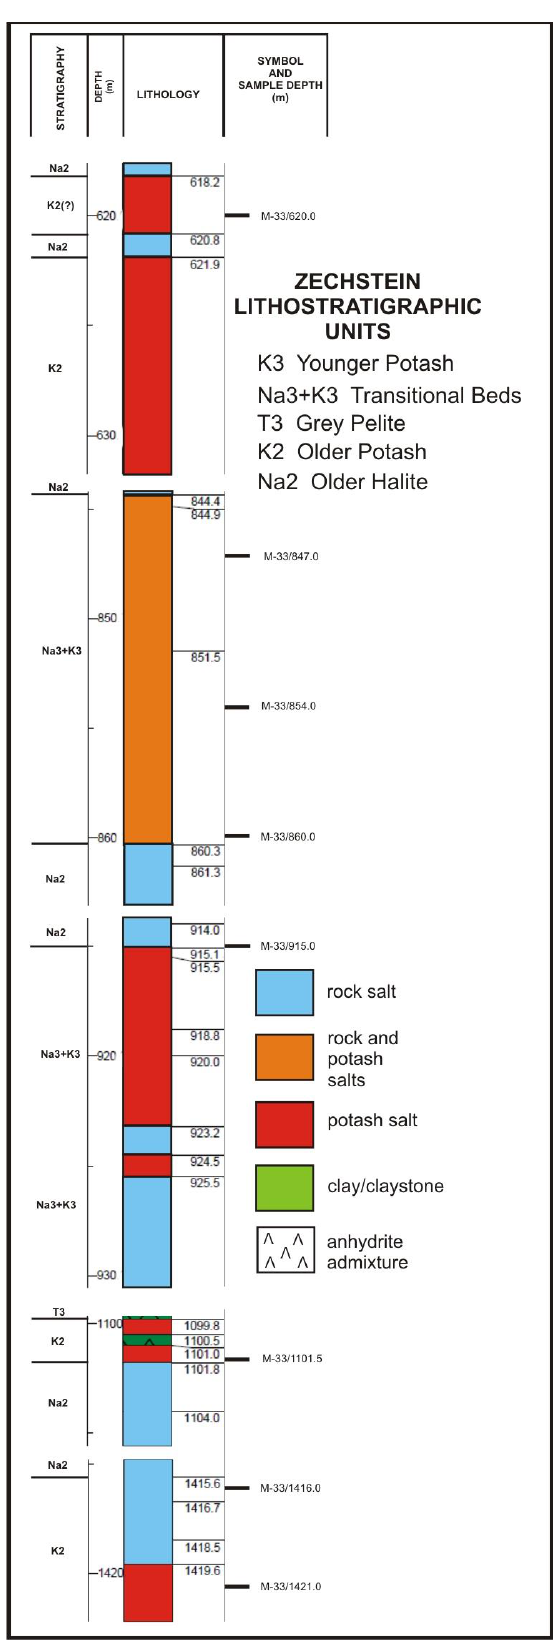
Figure 8. Sampled parts of the M-33 borehole profile with K2 and Na3+K3 lithostratigraphic units, Mogilno salt